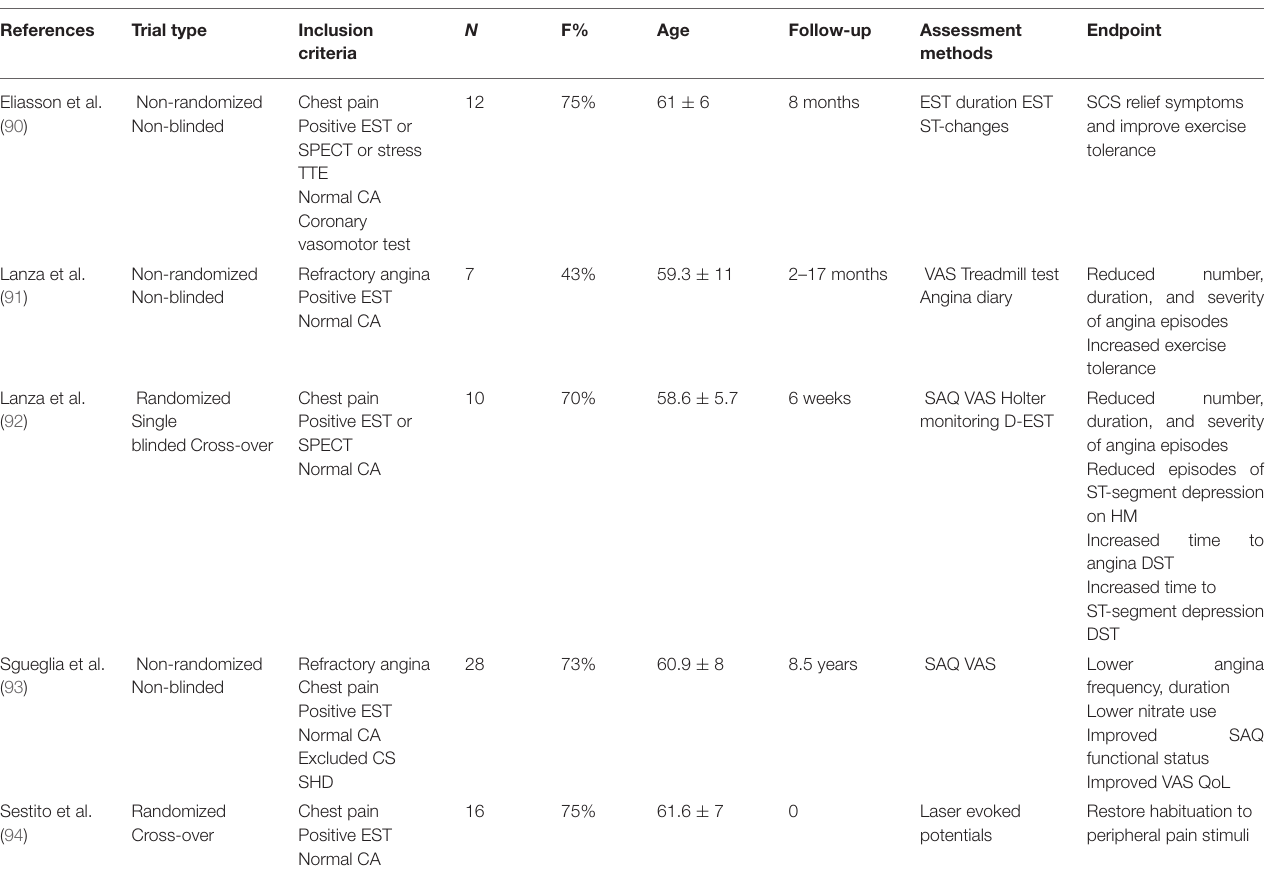
TABLE 3 | Interventional studies investigating spinal cord stimulation in